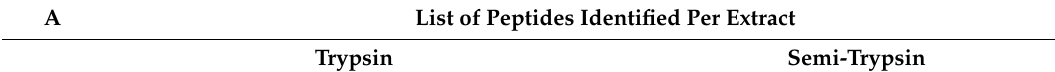
Table 5. ( A ) List of the peptides identified by proteomics, in each of the four tested fractions, according to two stringencies: trypsin and semi-trypsin modes. ( B ) Shared peptides by extract, compared two by two (the common denominator refers to the number of peptides identified in the reference